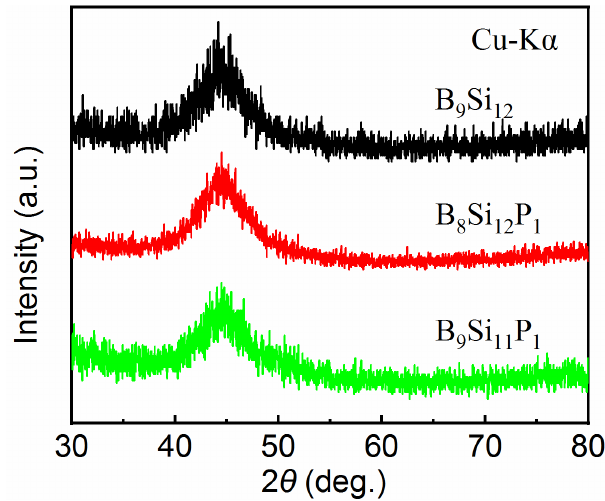
Figure 1. XRD patterns of melt-spun Fe 76 Cu 0.8 Nb 2.2 B 9 Si 12 (B 9 Si 12 ), Fe 76 Cu 0.8 Nb 2.2 B 8 Si 12 P 1 (B 8 Si 12 P 1 ) and Fe 76 Cu 0.8 Nb 2.2 B 9 Si 11 P 1 (B 9 Si 11 P 1 ) ribbons.